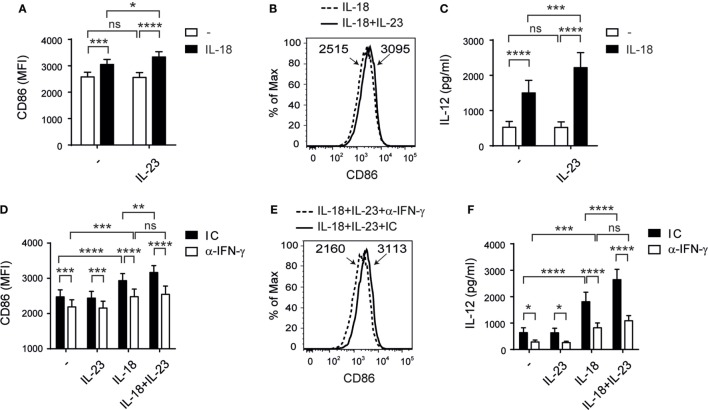
Interleukin (IL)-23 cooperates with IL-18 for natural killer (NK)-driven dendritic cells (DC) activation. (A–C) CD86 expression on DC (A,B) and IL-12 secretion by DC (C) after incubation with LPS and NK cells pre-cultured in the absence (−) or in the presence of IL-23, IL-18, or IL-23 and IL-18 (IL-18 + IL-23); n = 11. Representative histograms of CD86 expression on DC cultured with NK cells pre-stimulated with IL-18 or IL-18 and IL-23 (IL-18 + IL-23) are shown in (B). (D–F) CD86 expression on DC (D,E) and IL-12 secretion by DC (F) after incubation with LPS and NK cells pre-cultured in the absence (−) or in the presence of IL-23, IL-18, or IL-23 and IL-18, in the presence of an IC mAb (black bars) or an anti-IFN-γ neutralizing mAb (white bars); n = 9. Representative histograms of CD86 expression on DC cultured with NK cells pre-stimulated with IL-18 and IL-23, in the presence of an IC mAb or an anti-IFN-γ neutralizing mAb are shown in (E). Numbers within histograms represent the MFI of CD86 in each condition. Data are shown as mean ± SEM in panels (A,C,D,F). ns, no significant; *p < 0.05; **p < 0.01; ***p < 0.001; ****p < 0.0001; two-way ANOVA with repeated measures matched by both factors and Bonferroni’s post hoc test (A,C,D,F). The interaction p-values (synergism) were: p = 0.0287 (A) and p = 0.0028 (C).